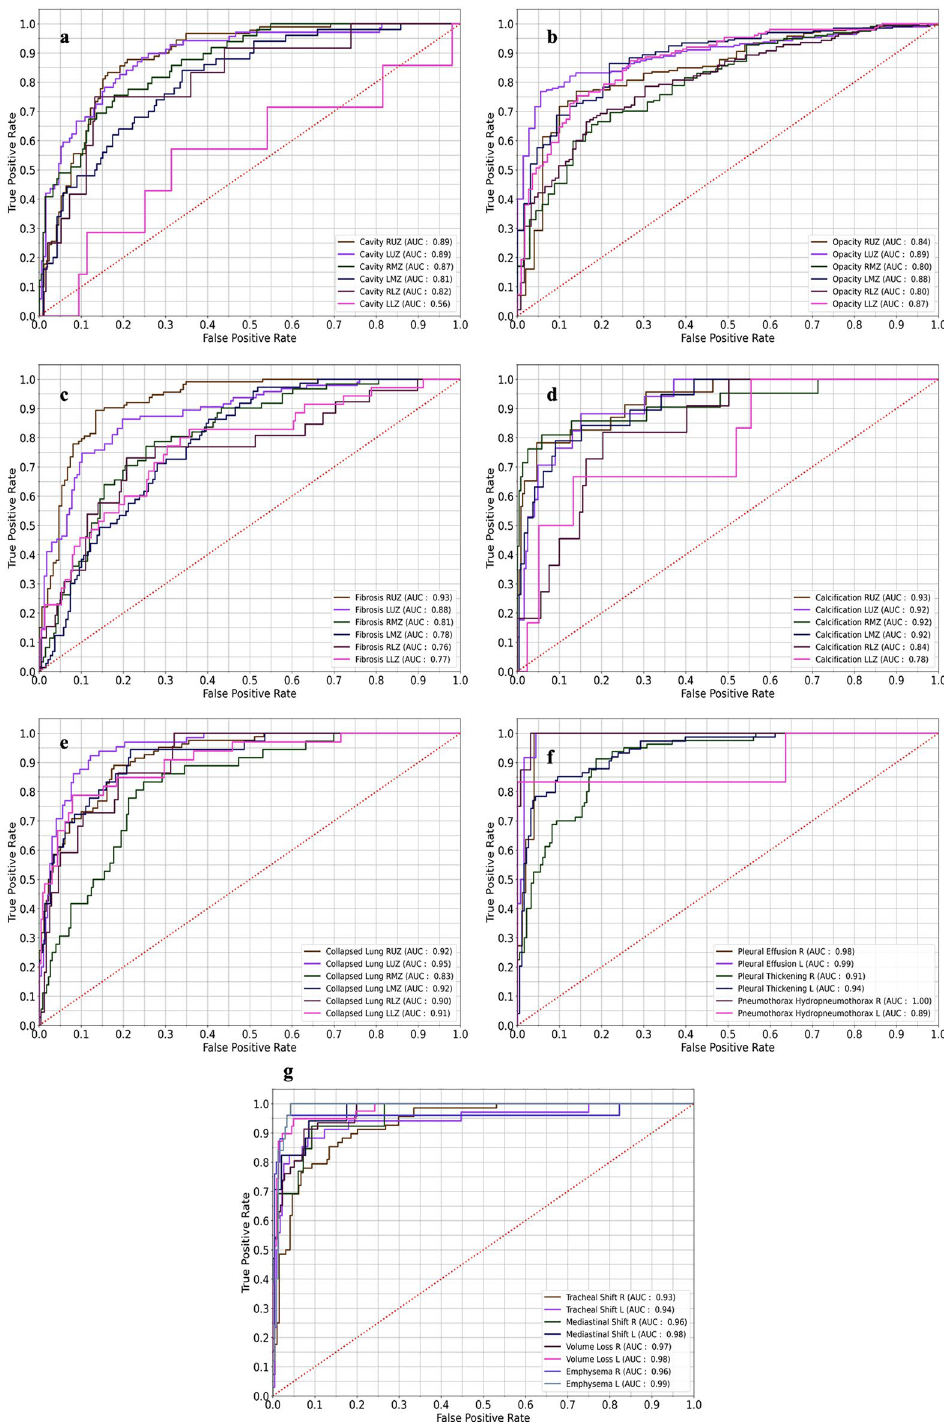
Figure 2. Receiver operating characteristic of lung zone wise abnormalities. ( a ) Area under receiver operating characteristic (AUC) of cavity. ( b ) AUC of opacity. ( c ) AUC of fibrosis. ( d ) AUC of calcification. ( e ) AUC of collapsed lung. ( f ) AUC of pleural effusion, pleural thickening, pneumo/hydropneumothorax. ( g ) AUC of tracheal shift, mediastinal shift, volume loss, emphysema. RUZ right upper zone, RMZ right mid zone, RLZ right lower zone, LUZ left upper zone, LMZ left mid zone, LLZ left lower zone, R right lung, L left